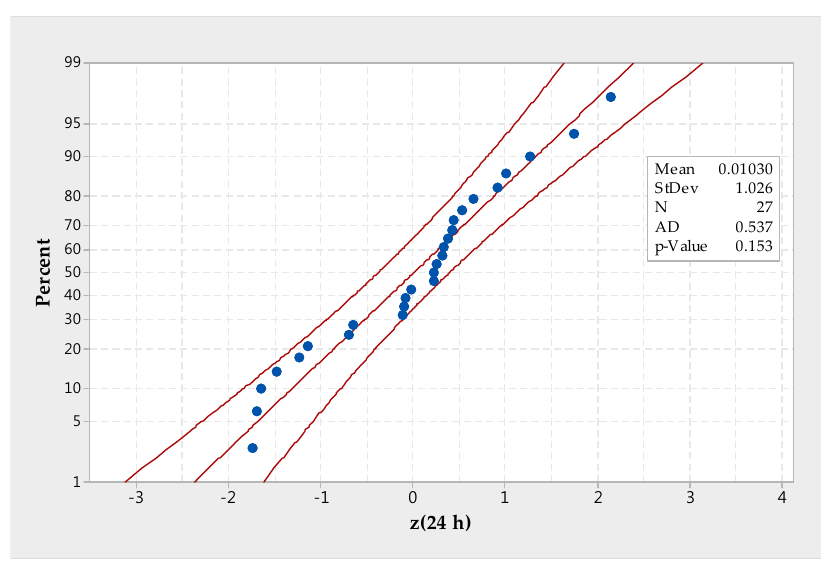
Figure 5. Probability plot of normalized 24 h rainfall